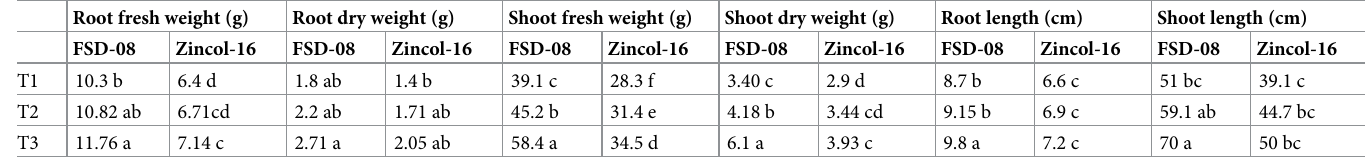
Table 1. Interaction of salinity and exogenously applied caffeic acid on fresh and dry biomass of two wheat genotypes. Values depict the mean of four replicates and figures not sharing the same letter in each column differ significantly at 0.05 probability level. Treatments include (T 1 ) Control (Saline field with EC 8.7 d S m -1 ), (T 2 )